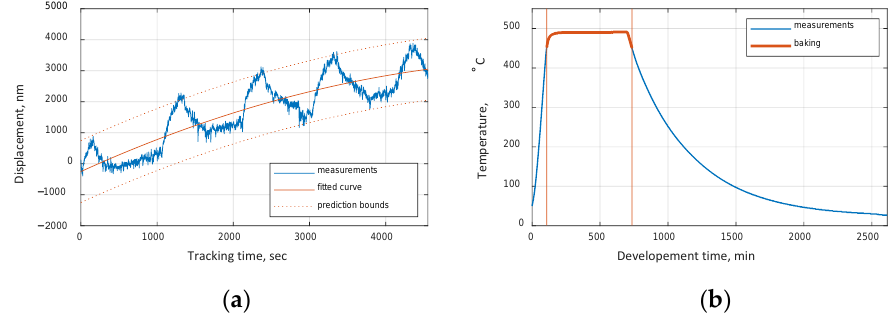
Figure 2. Recording and development conditions: ( a ) Vibration / time conditions during recording, ( b ) temperature / time dependence during baking.